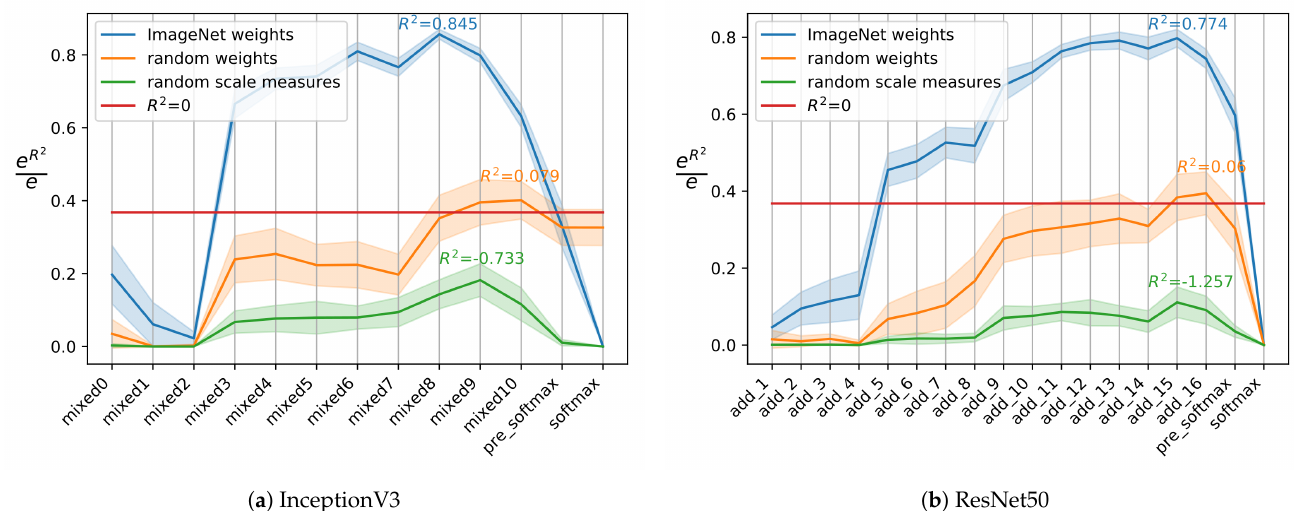
Figure 8. Comparison of regression (RCV) of scale measures at different layers on the albatross ImageNet class (ID: n02058221). The regression is evaluated as the R 2 of the prediction of scale measures on held-out images and e R for better visualization. Values above the red line R 2 = 0 show a predictive regression better than the average of ratios r . Average and standard deviations are reported for 25